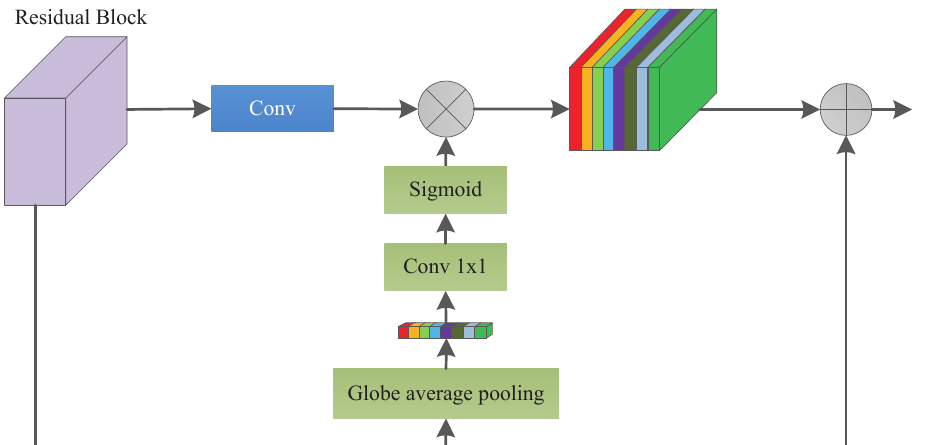
Figure 3. Architecture of the Attention Module